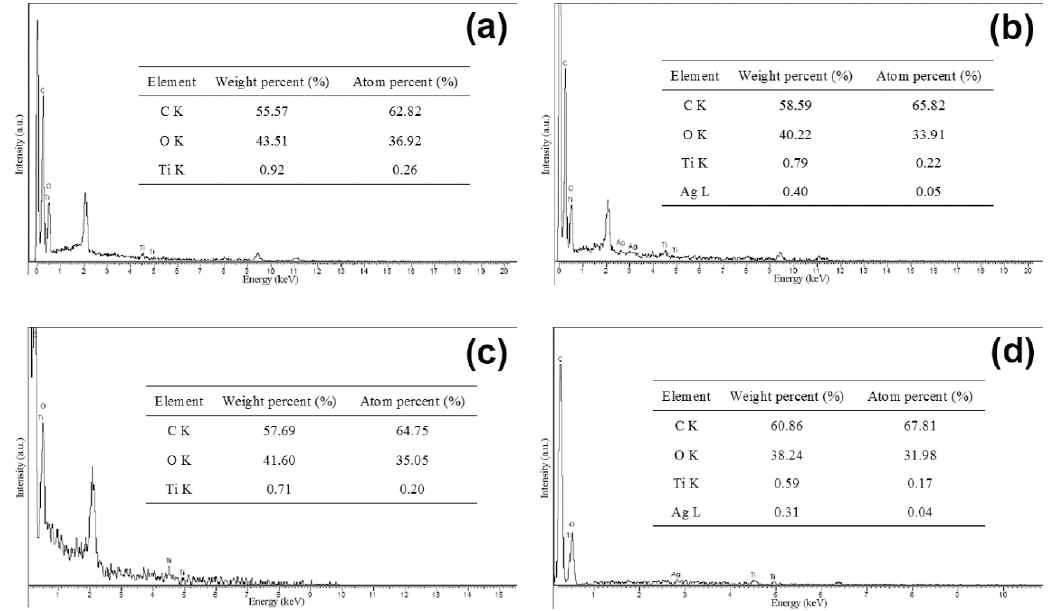
Figure 2. The energy-dispersive X-ray spedctroscopy (EDS) spectra of the ( a ) P–1, ( b ) P–2, ( c ) TiO 2 coated and ( d ) Ag-doped TiO 2 coated PET